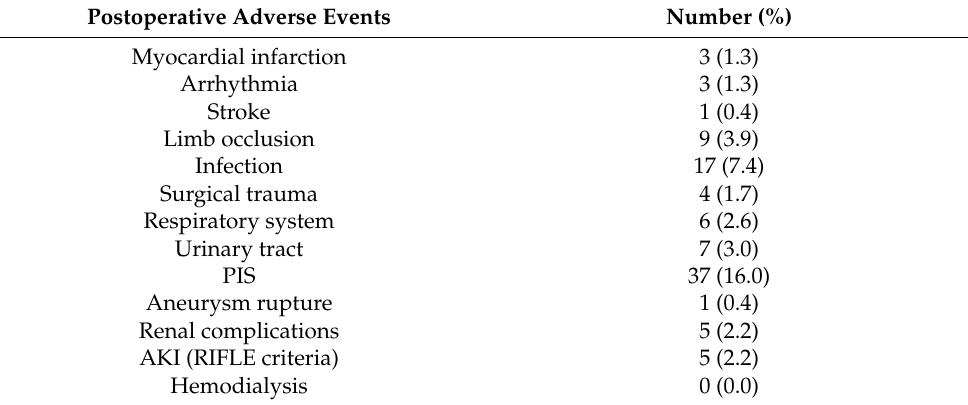
Table 3. All adverse events during the early follow-up in patients that underwent elective EVAR.